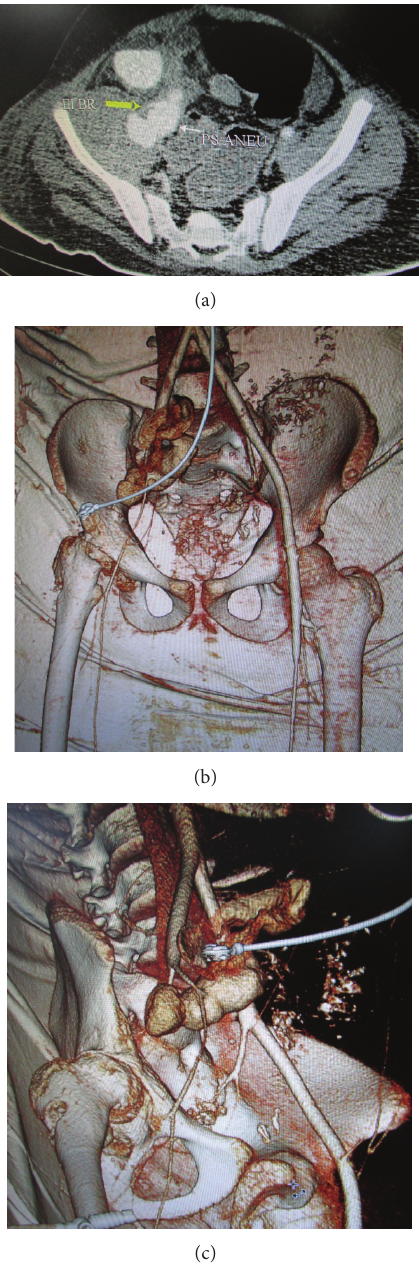
Figure 3: (a) Axial computerised tomography (CT) angiography image showing a branch of external iliac artery (EI BR) feeding the pseudoaneurysm (PS ANEU). (b) and (c) 3D reconstruction CT angiography images showing branch of the external iliac artery feeding the large bowel